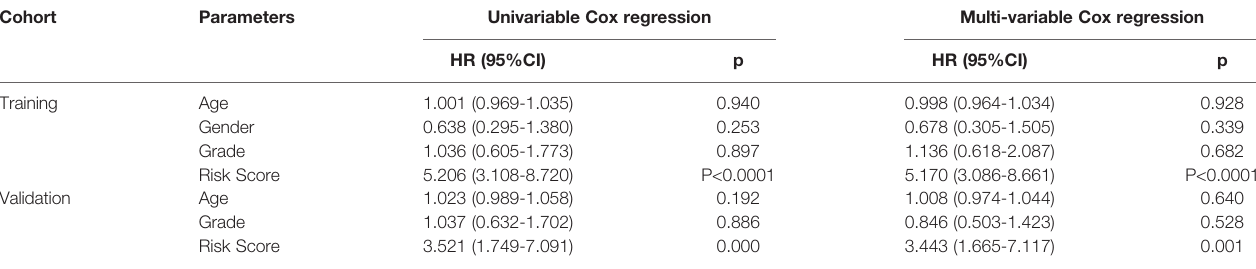
TABLE 3 | Uni- and multivariate cox regression analysis both in the training and validations